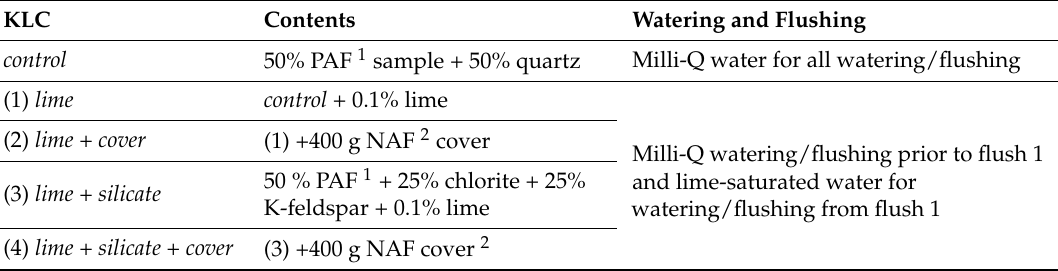
Table 1. The composition (wt %) and watering/flushing of the